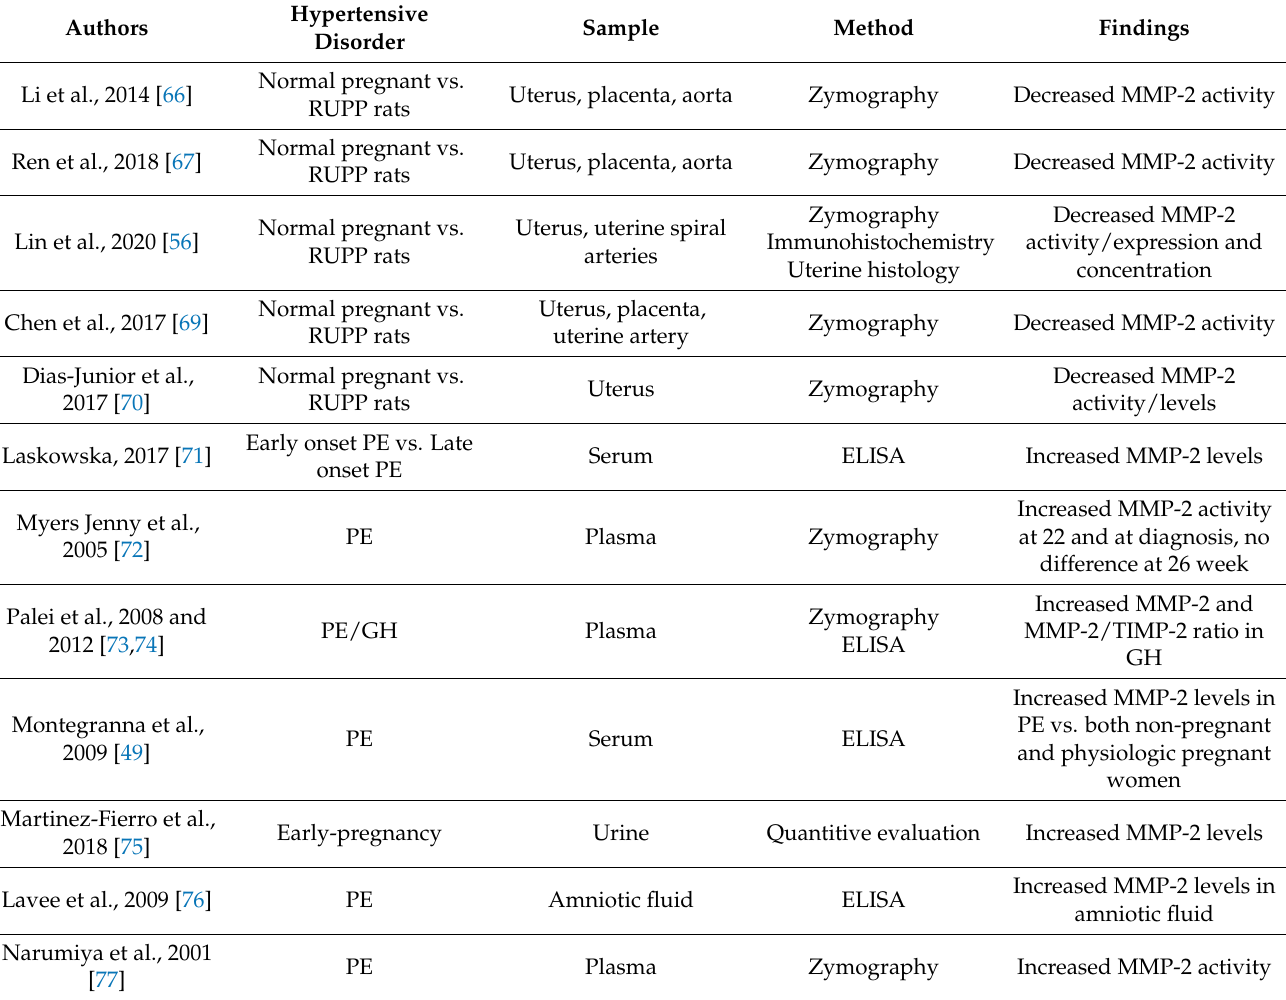
Table 1. Levels of MMP-2 in samples of patients with hypertensive disorders of